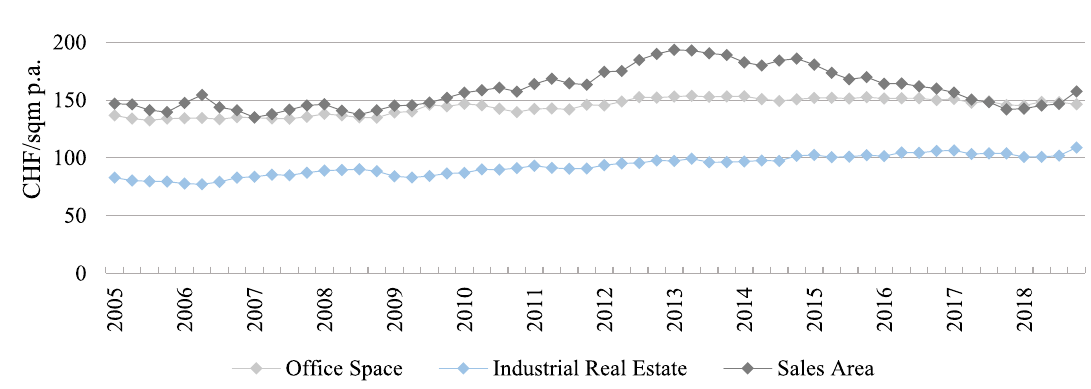
Fig. 6 Commercial real estate—real estate prices. Notes : Average median real estate prices, measured in rental prices per square meter and year (CHF/sqm p.a.), across 106 MS-regions of Switzerland for office space, sales area and industrial real estate between 2005 Q1 and 2018 Q4. Source : Wüest Partner